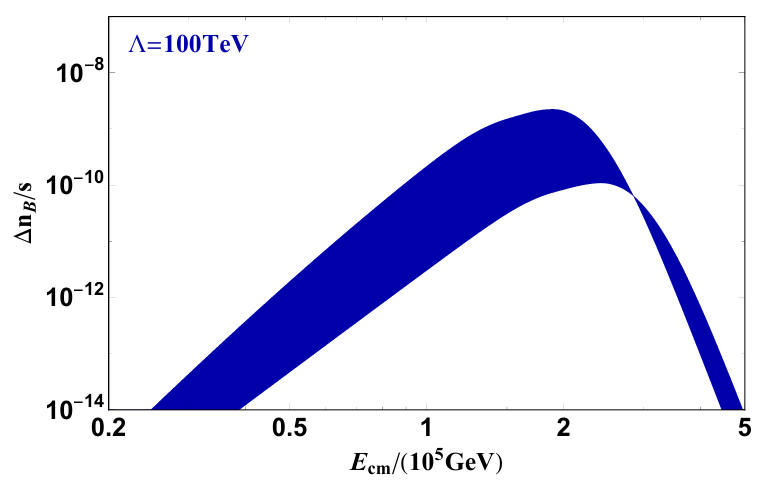
Figure 3 . The numerical result for the baryon asymmetry generated by the (cid:12)rst scatterings by vary- ing E cm = m (cid:30) T R with T R = 90 GeV and (cid:3) = 100 TeV. The other parameters are same as (cid:12)gure